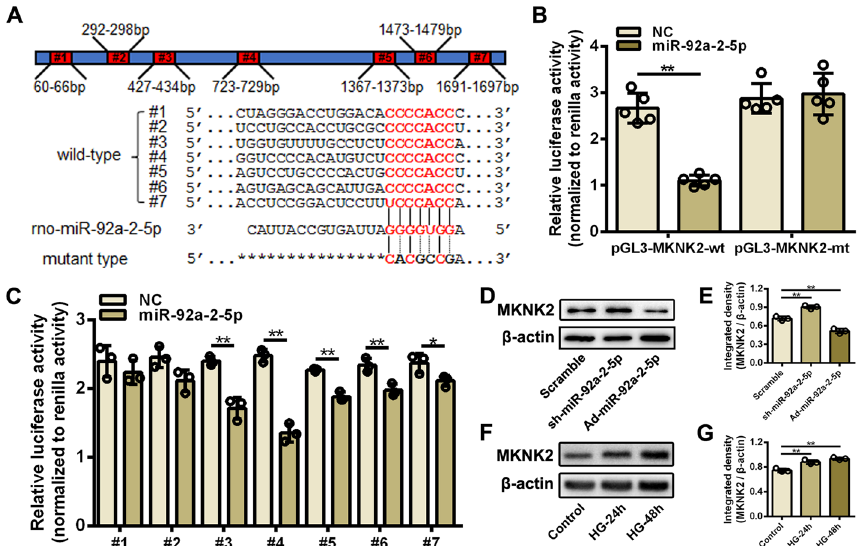
Fig. 4 MKNK2 was a novel target of miR-92a-2-5p in cardiomyocytes. A Schematic representation of the full-length 3’UTR of rat MKNK2 mRNA. #1—#7, potential binding sites of miR-92a-2-5p. B , C